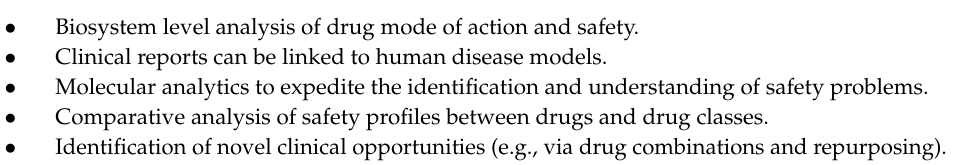
Table 2. Benefits of molecularly exploring clinical reports. Integrating AEs together with drug